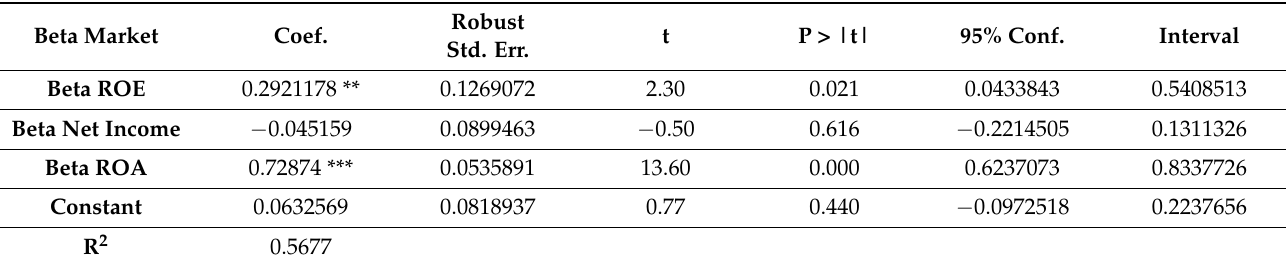
Table 9. Regression analysis corrected for